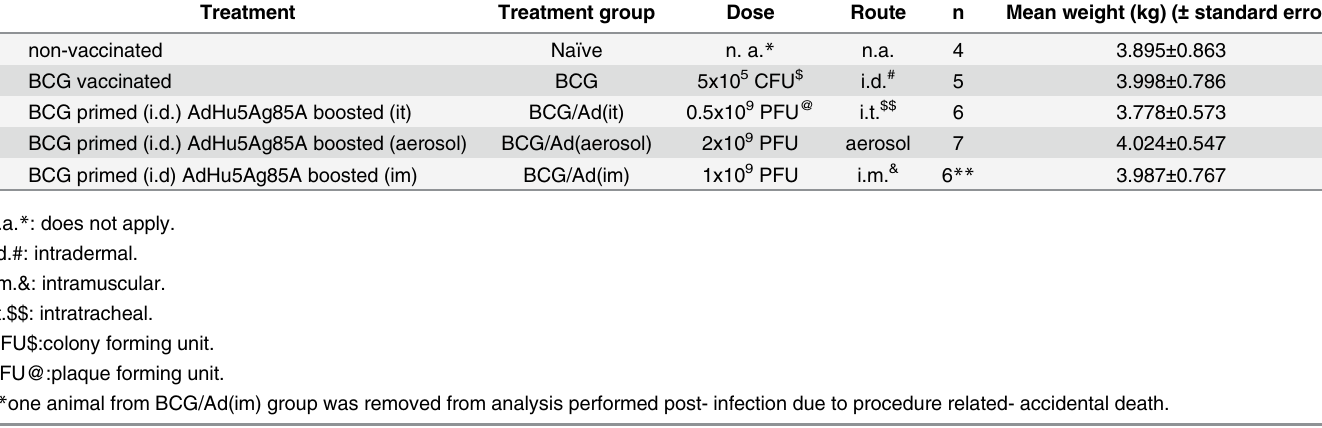
Table 1. Timelines for immunization and measurements of safety assessments are depicted in the experimental schema (Fig 1). Appetite, acute phase C-reactive protein (CRP), erythrocyte sedimentation rate (ESR) and body temperature (Tem) indicative of systemic inflammation, were measured 3 weeks (wk17) and chest X-ray taken 6 weeks (wk20) post-AdHu5Ag85A boost and before infection (Fig 1). Compared to pre-immunization measurements there were no remarkable changes observed in the appetite, ESR and CRP levels post-immunization (Table 2). No unusual body temperature fluctuations were observed in animals of all treatment groups; and body temperature of animals in BCG/Ad (aerosol) group increased slightly after AdHu5Ag85A boost (Table 2). The chest X-ray remained normal in all boosted groups com- pared to the controls (Table 2). Taken together, these data suggest that respiratory mucosal delivery of AdHu5Ag85A vaccine is safe in parenteral BCG-primed NHP.